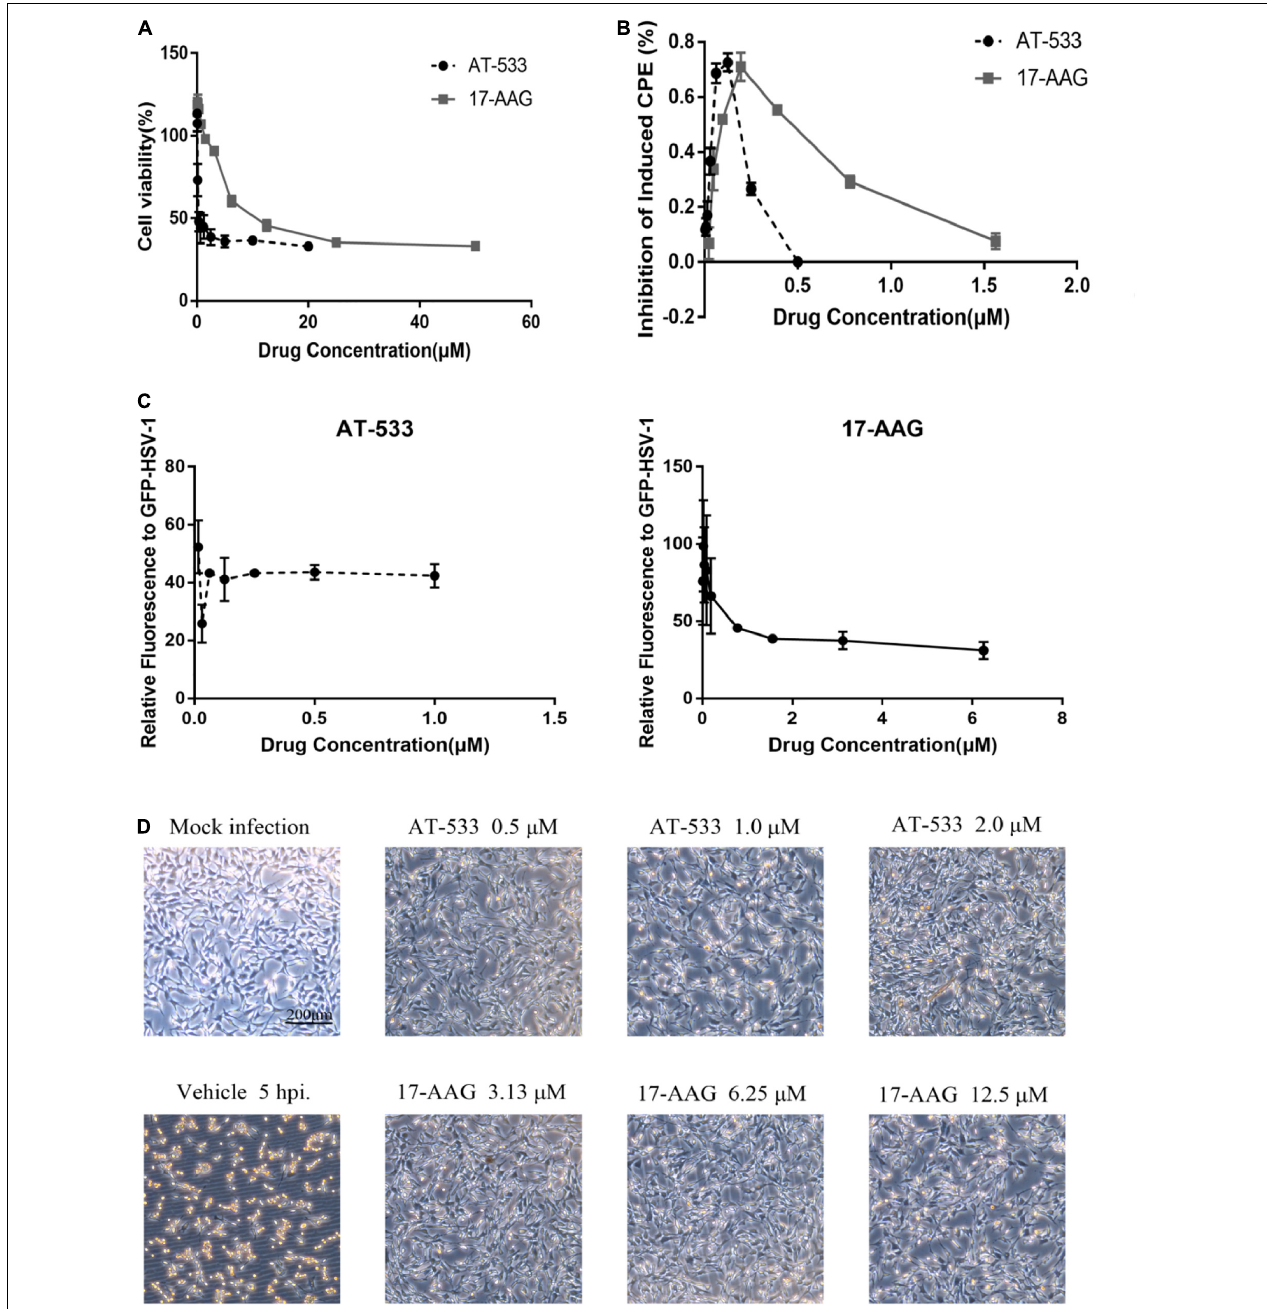
FIGURE 1 | Cytotoxicity and anti-HSV-1 activity of AT-533 and 17-AAG. (A) Human foreskin fibroblast cell monolayers were treated with concentration-gradient AT-533 and 17-AAG for 48 h and were manipulated to CCK-8 assay. (B) HFF cell monolayers were treated with concentration-gradient AT-533 and 17-AAG for 48 h and were manipulated to CPE reduction assay. (C) HFF cells were infected with GFP-HSV-1 (MOI = 20) and treated with AT-533 and 17-AAG. After infection for 72 h, the relative fluorescence of GFP-HSV-1 was assessed. Data are shown as means ± SEM. (D) HFF cells were infected with HSV-1 (MOI = 20) and treated with AT-533 and 17-AAG at 5 hpi, and the morphology of cells was observed in scale 200 µ m at 12